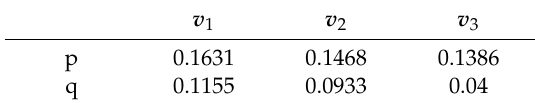
Table 4. Degree table of disagree-neutrosophic soft expert multiset.